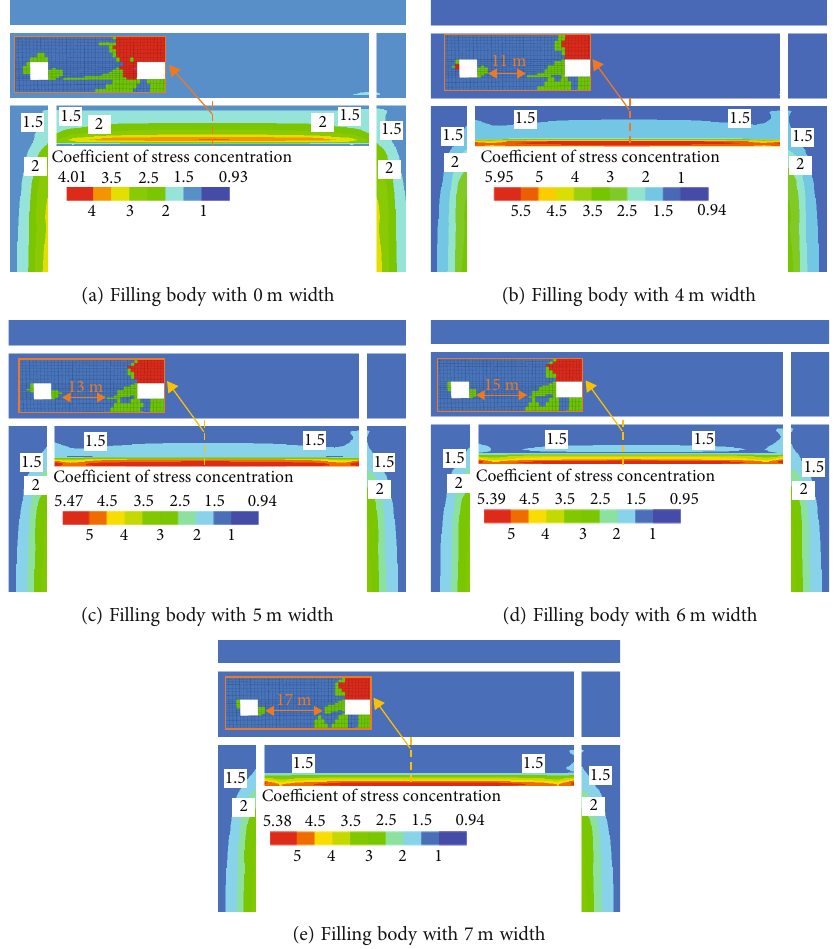
Figure 11: Distribution law of elastic zone and stress concentration factor.